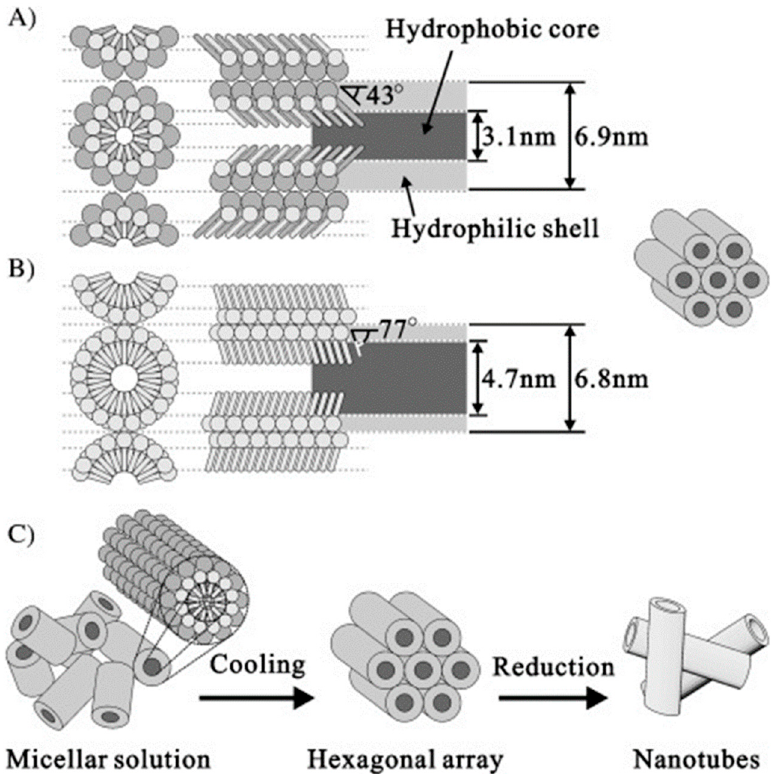
Figure 4. Schematic representation of the formation of platinum nanotubes in the mixed surfactant templating system as shown by Kijima et al.: ( A ) mixed (C 12 EO 9 /Tween 60) and ( B ) single (C 12 EO 9 ) surfactant cylindrical rodlike micelles. ( C ) Pathway from the micellar solution to metal nanotubes by the reduction of metals salts confined to the aqueous shell of mixed-surfactant cylindrical micelles. The metal salts and water molecules are omitted from the diagram. Reprinted with permission from Kijima et al., Angew. Chem. Int. Ed. Engl. 2004 , 43 228.